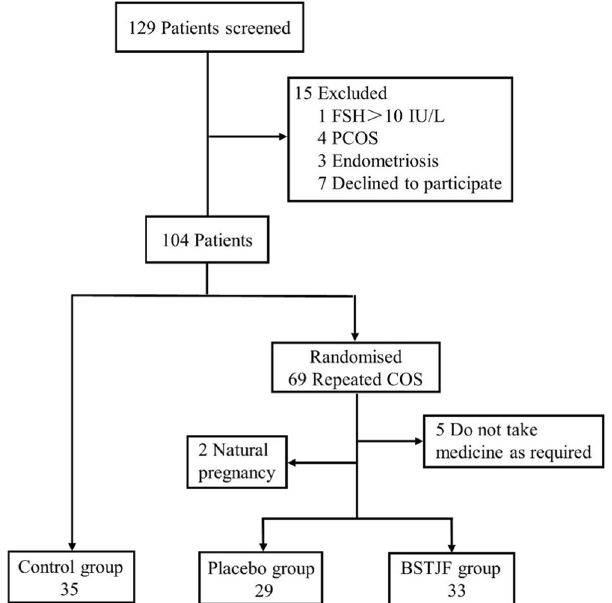
Figure 5. Flow diagram of inclusion of patients in the groups. COS controlled ovarian stimulation, BSTJF